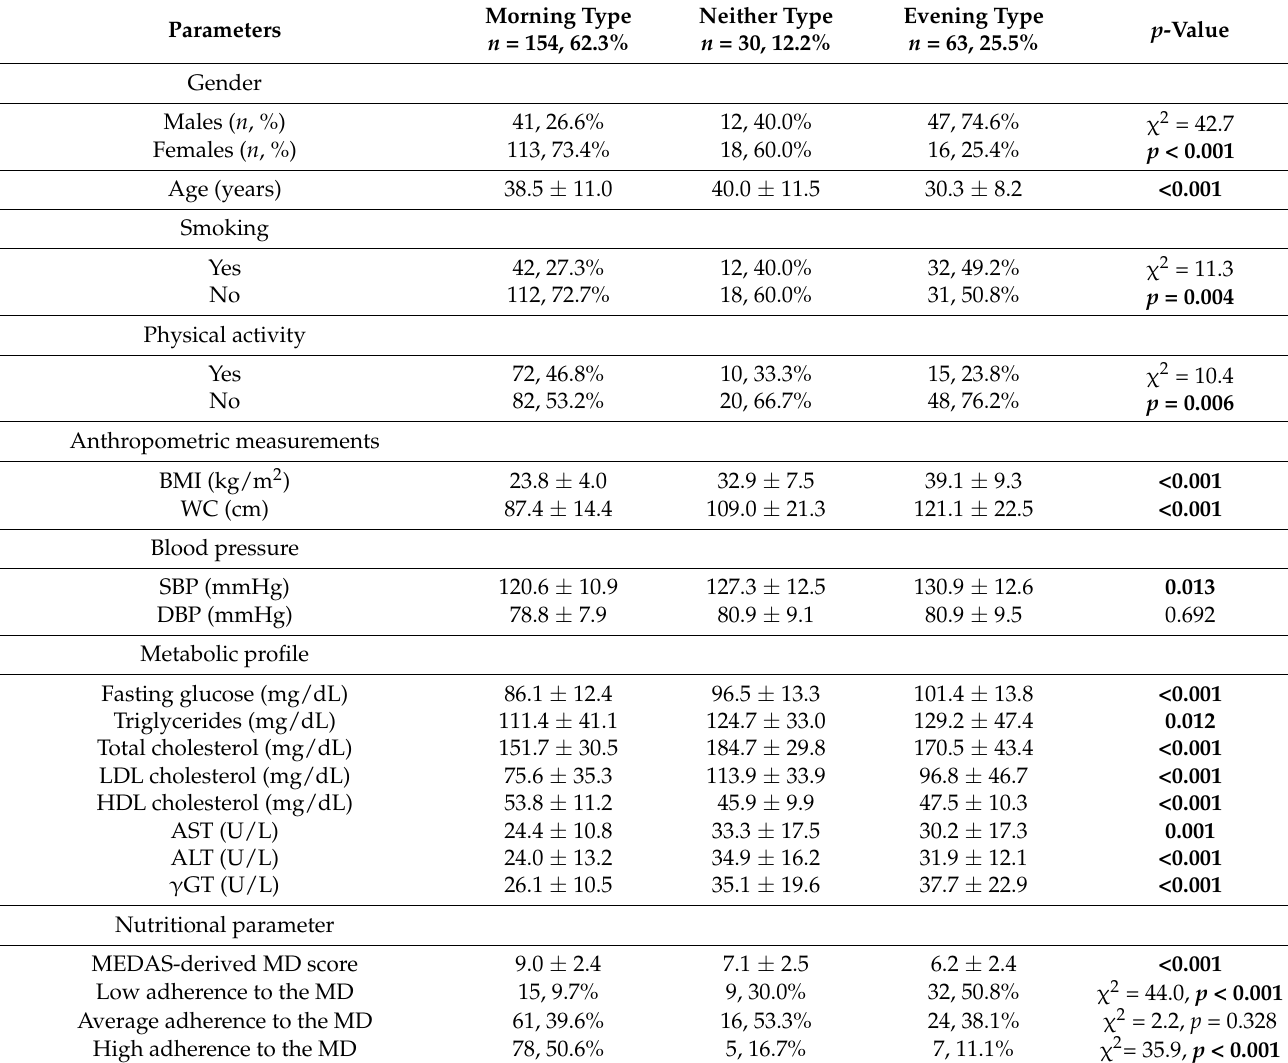
Table 3. Sex, age, lifestyle habits, anthropometric measurements, blood pressure, metabolic profile, and nutritional parameter in the study population grouped based on chronotype categories.